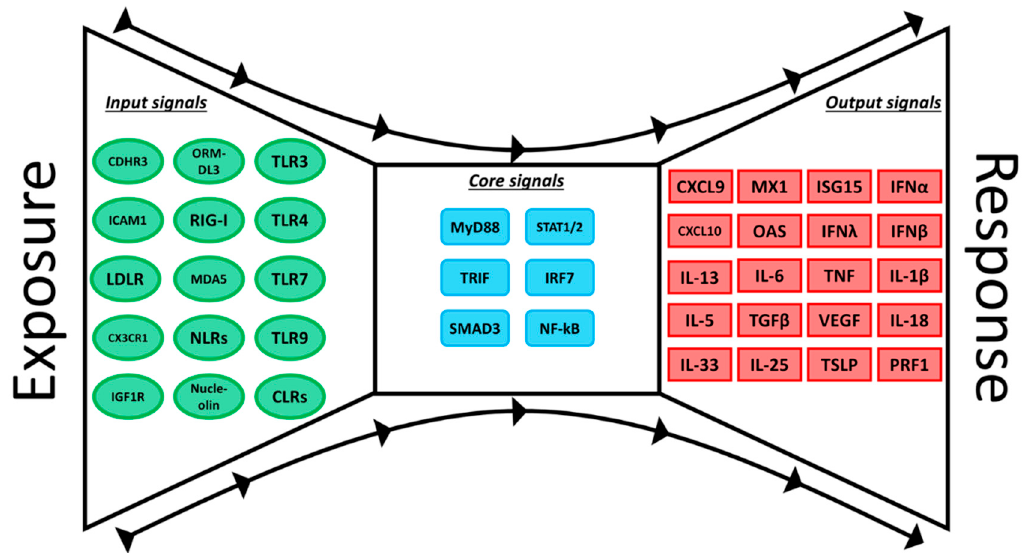
Figure 1. The innate immune system is governed by a Bow-tie architecture. The Bow-tie structure enables diverse input signals to converge on a few core pathways, which in turn drive functional responses through the actions of a large number of effector and regulatory molecules. We have